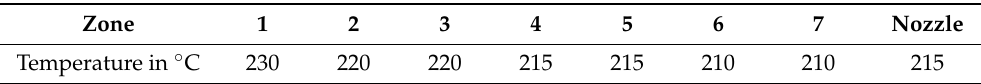
Table 2. Temperature profile (setpoints) of the twin-screw extruder.